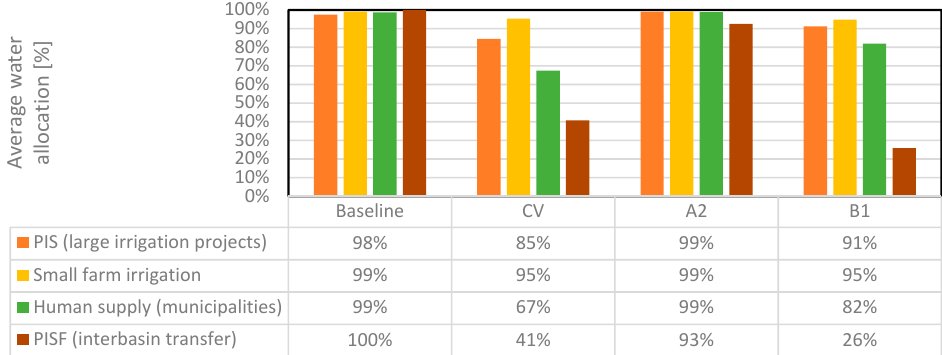
Figure 6. Water allocation of the consumptive uses of water in the scenarios: Climate Variability (CV), Fragmentation (A2), Global Consciousness (B1).